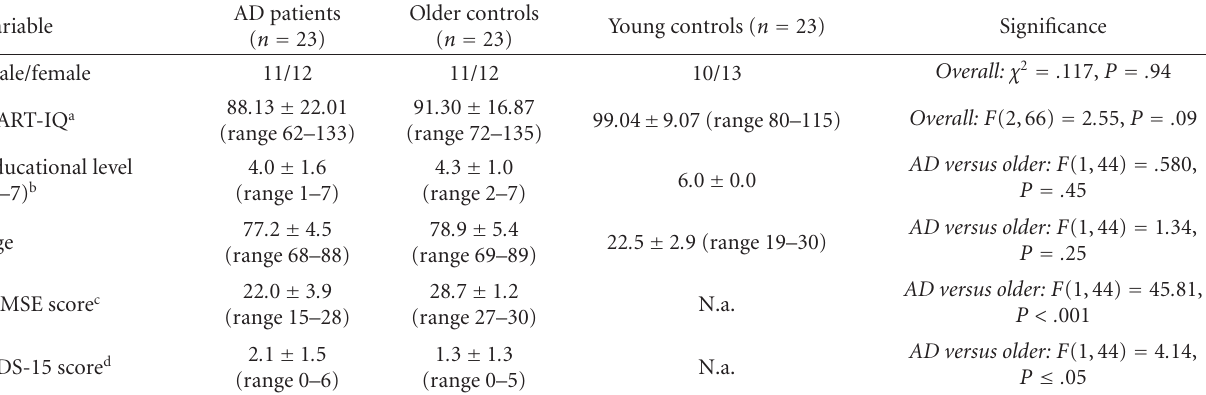
Table 1: Demographic variables, MMSE, GDS-15 and NART-IQ scores in the AD group, the older control group and the younger control group ( N = 69).